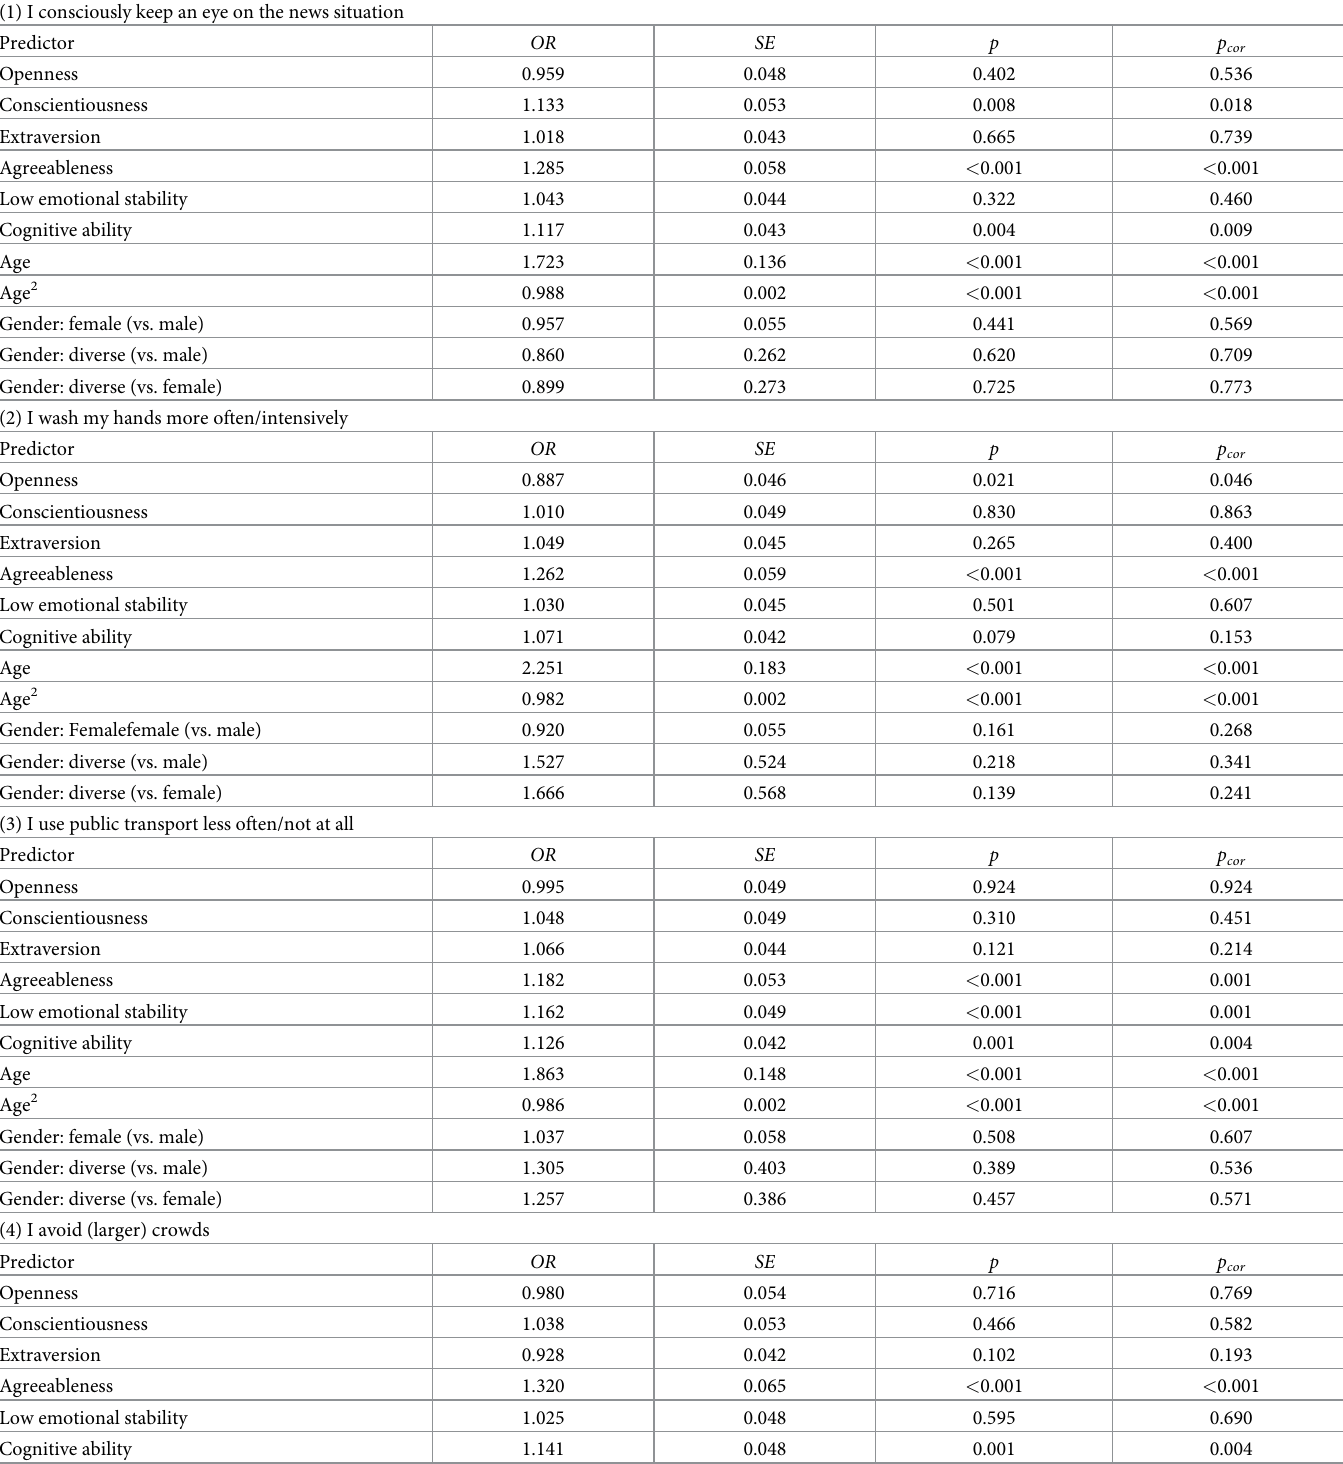
Table 2. Associations between the Big Five personality traits and students’ thoughts, feelings, and behaviors during the first three weeks of the COVID-19 pandemic in